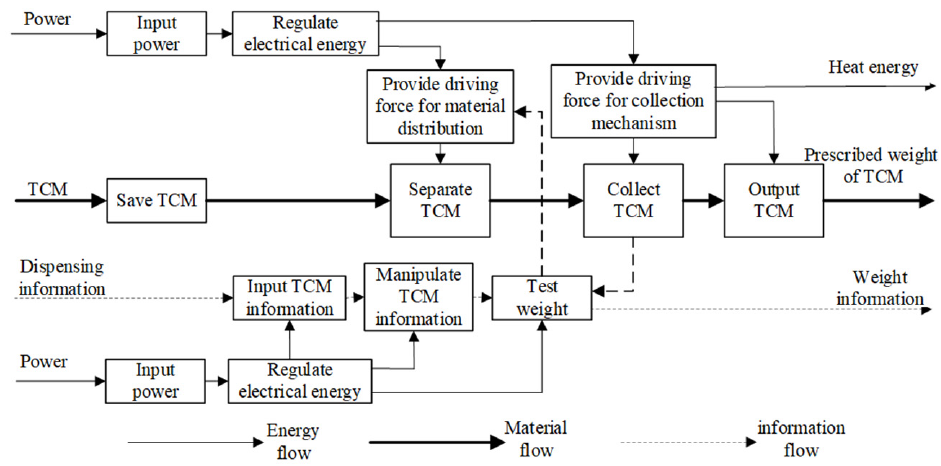
Figure 14. Functional structure of powder granular bulk TCM grasping machine.